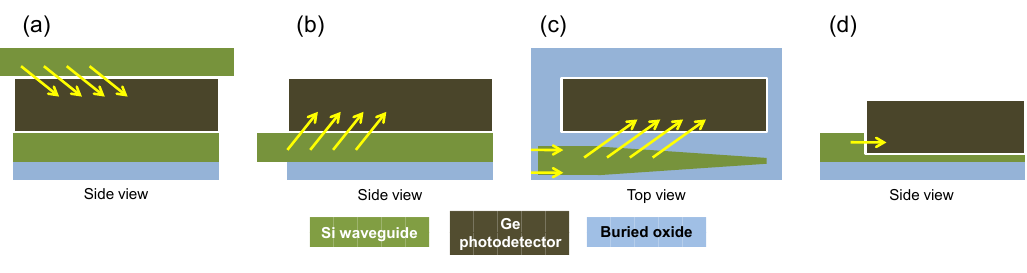
Figure 3: Waveguide-to-detector coupling configurations. Evanescent-coupling schemes: (a) top-to-down, (b) down-to-top, and (c) side-coupling. (d) Butt-coupling